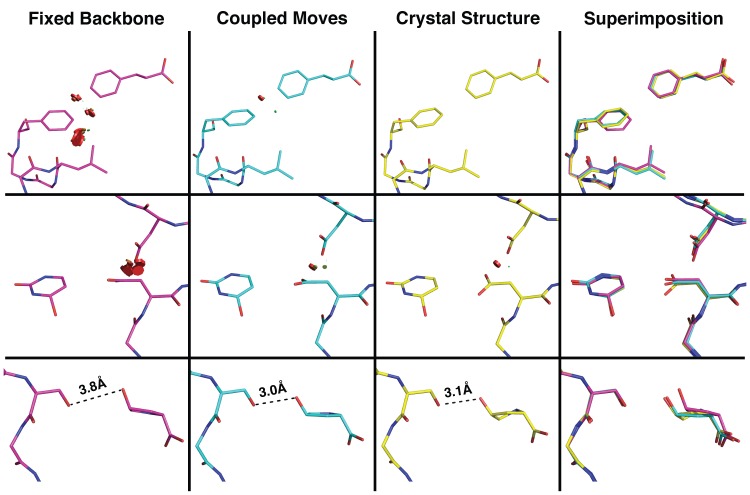
Comparison of models for specificity altering mutations from fixed backbone and coupled moves methods, and crystal structures.Each row displays an example specificity altering mutation from fixed backbone (magenta) or coupled moves (cyan) models, as well as the crystal structure (yellow) and the superimposition of all three (far right column). Red disks denote steric clashes and dashed black lines denote hydrogen-bonding interactions.